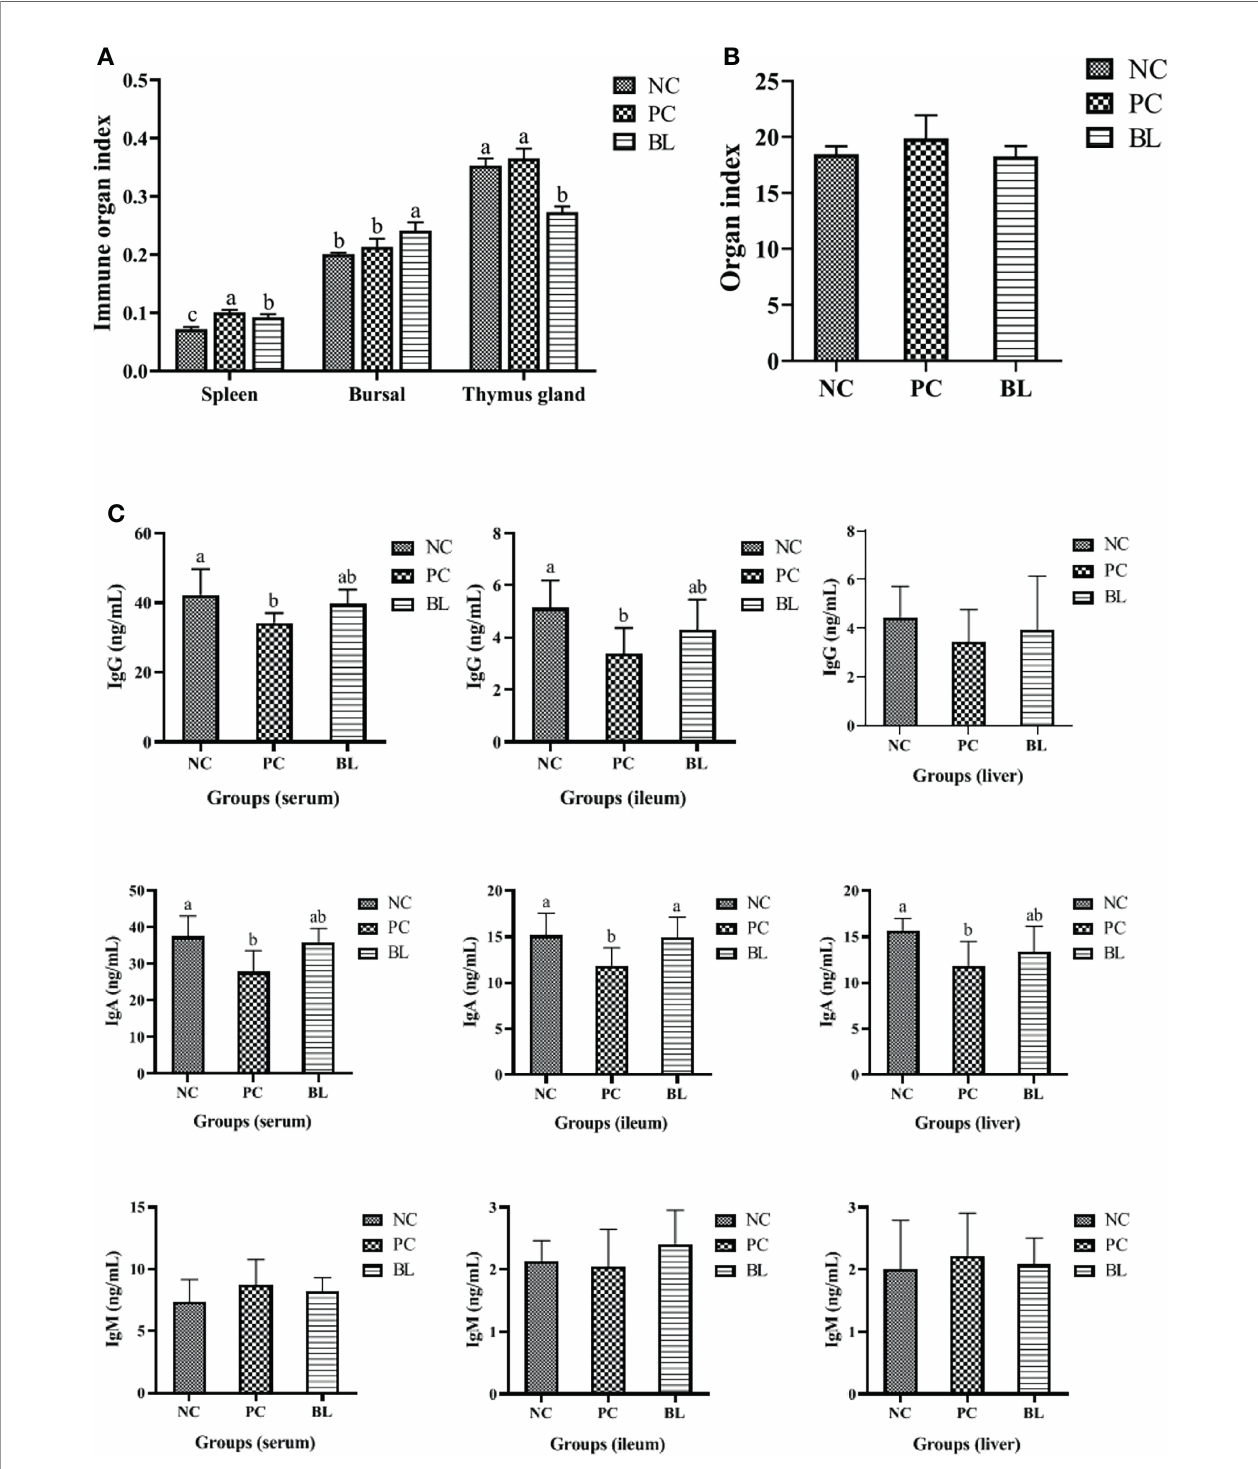
FIGURE 4 | Probiotic H2 ameliorates the in fl ammatory response and increases the immunity of SNE-infected broilers. (A, B) Comparison of organ indexes from thymus gland, bursa, spleen, and liver (n = 4, mean with SD). (C) Protein contents of IgG, IgA, and IgM were determined in the serum, ileum, and liver of broiler chickens (n=6, mean with SD). a, b means different letters are signi fi cantly different ( P < 0.05). One-way ANOVA and adjustment for multiple comparisons were